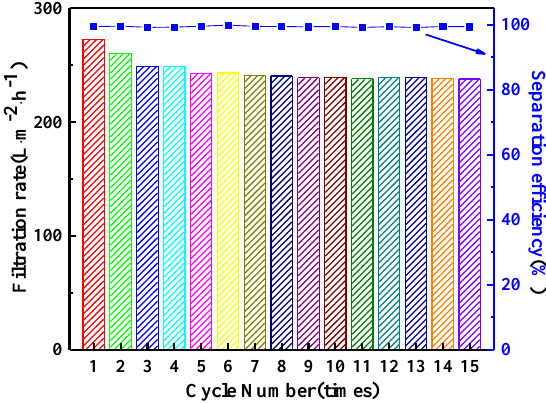
Figure 9. Filtration rate and separation efficiency filtration flux of the membrane M3-S for repeating separation experiment.